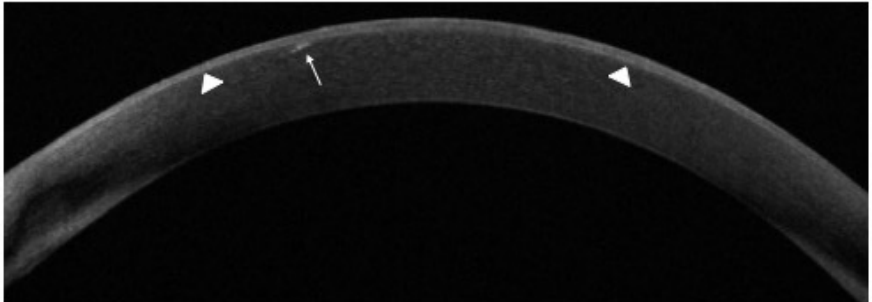
Figure 2. Anterior segment optical coherence tomography (AS-OCT) in a patient with belamaf keratopathy showing heterogeneous, diffuse corneal epithelium hyper-reflectivity corresponding to MECs (arrowheads), with a small hyper-reflective area extending to the anterior stroma associated with a focal interruption of the Bowman layer (arrow).